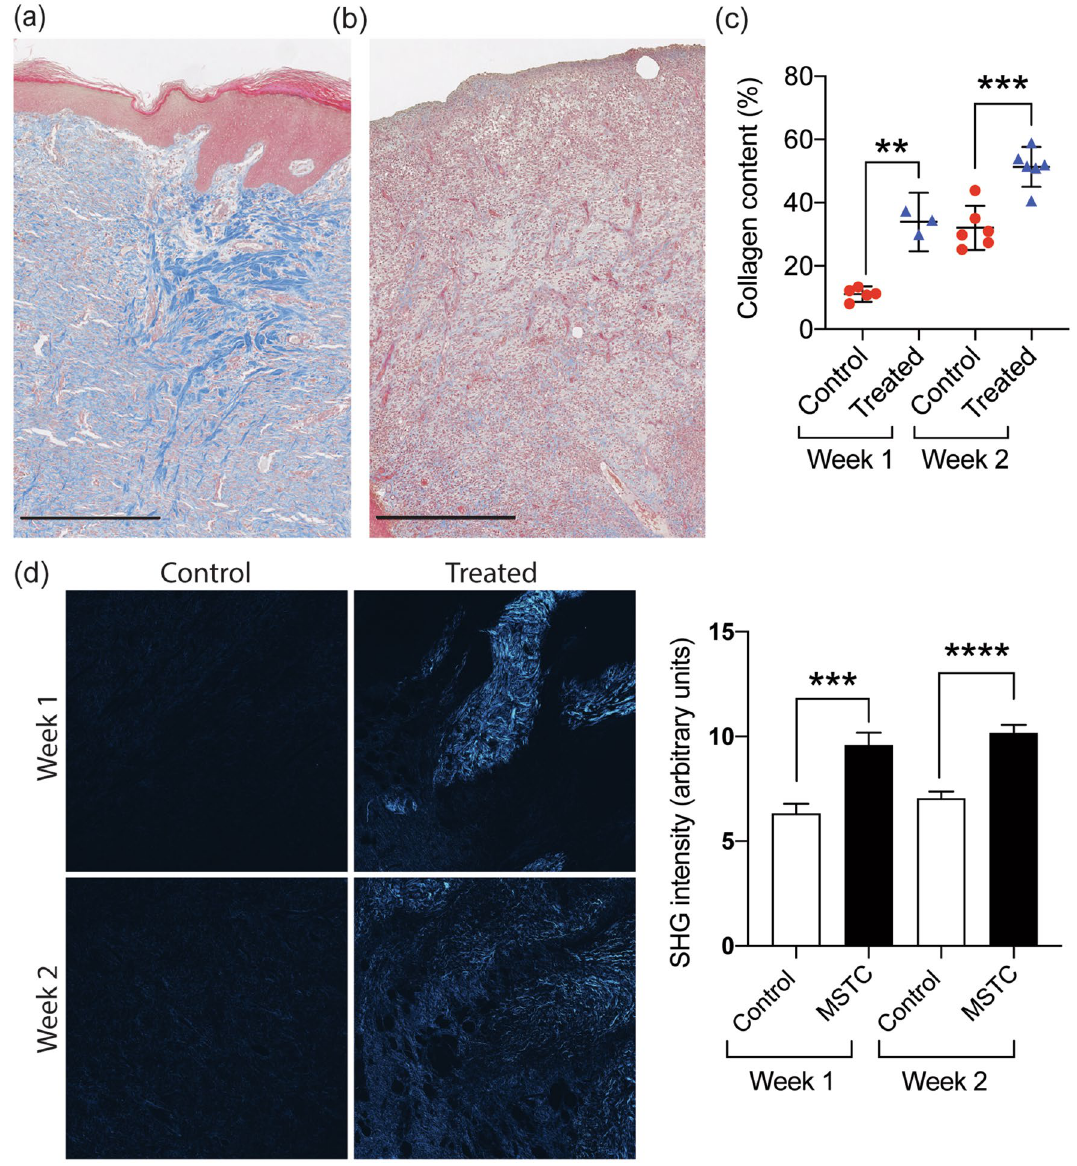
Figure 3. MSTC treatment increased dermal collagen content. Representative trichrome images of MSTC- treated ( a ) and control ( b ) wounds at 2 weeks. Collagen is stained in blue. Scale bars = 500 μm. Quantification of collagen staining shown in ( c ). MSTC-treated wounds had significantly higher collagen content at both 1- and 2-week time points. ( d ) Fibrillar collagen visualized by second-harmonic generation (SHG) imaging. At both time points there were discrete regions with strong SHG signal within MSTC-treated wounds, while SHG signal was largely absent in control wounds. Images shown represent images with intensities that are nearest the mean for each respective group. Each image is 1.9 mm wide. **p ≤ 0.005, ***p ≤ 0.0005, **** p ≤